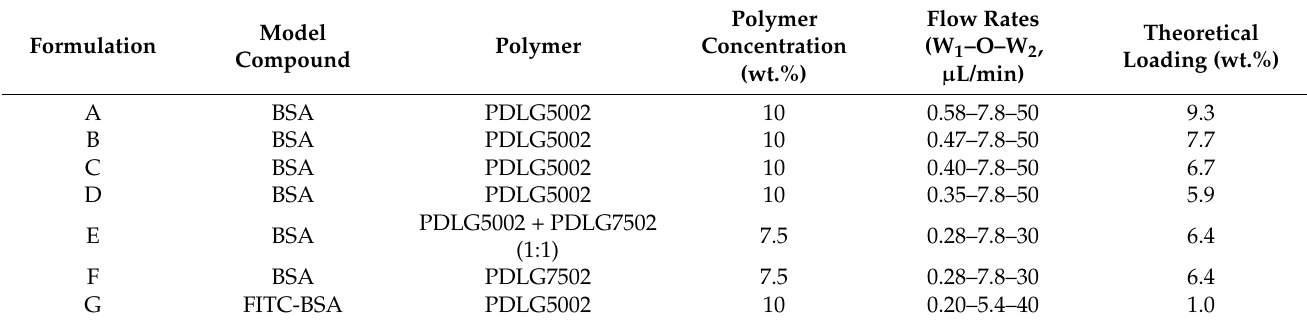
Table 1. Experimental parameters and settings of different bovine serum albumin (BSA)-loaded microsphere formulations.